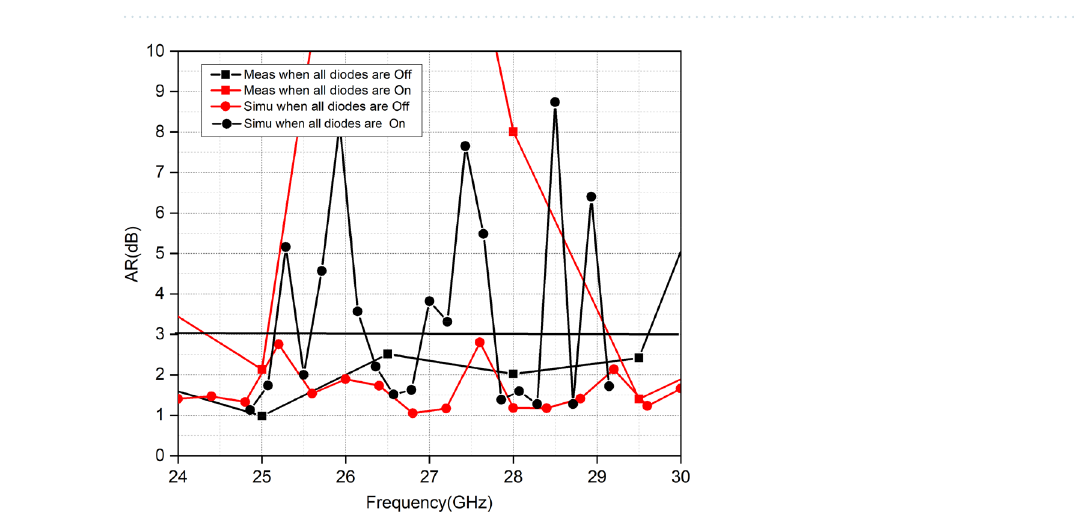
Figure 18. ( a , b ) Contrast of simulated and measured reflection and transmission coefficient without and with diodes respectively.